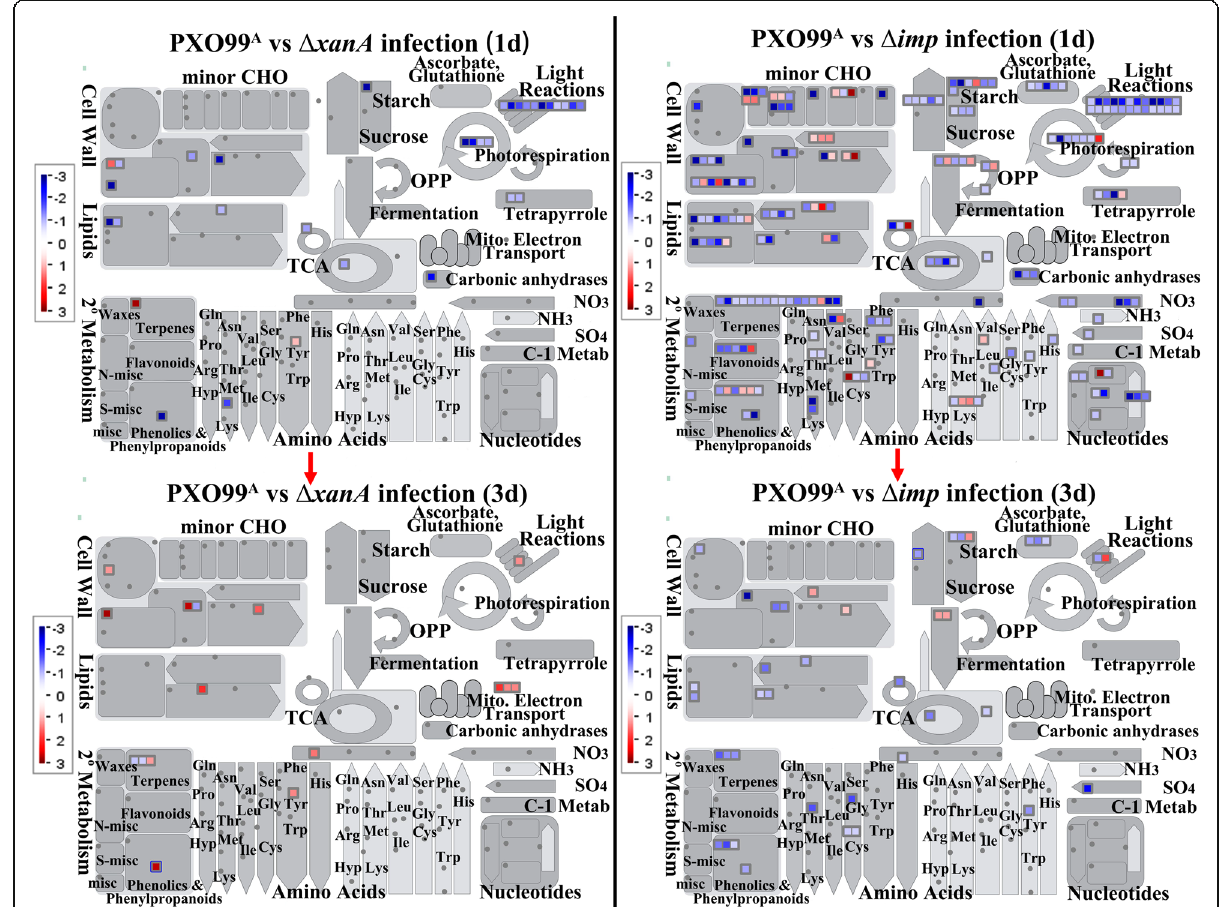
Fig. 6 MapMan analysis and comparison of the metabolic changes in IR24 rice at 1 and 3 d after infection with the mutants Δ xanA and Δ imp relative to those with PXO99 A infection. In each comparison group, the corresponding DEGs with |log2 (fold change)| ≥ 1 were imported into MapMan software. The gray circles indicate that no differentially expressed genes were matched in this process. The red and blue squares attached to each metabolic pathway represent up- and downregulated genes, respectively. The color intensity represents the gene expression level (log2 ratio mutant/PXO99 A ), as indicated by the color scale. Detailed information is shown in Table